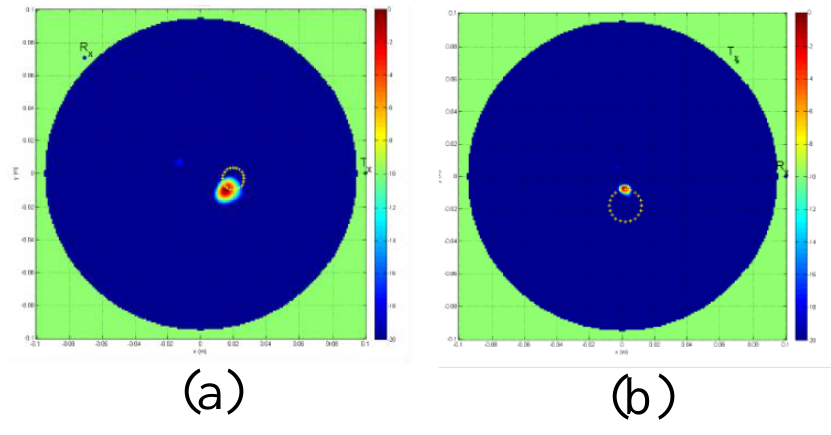
Figure 13. Reconstructed MT images obtained using the system developed by Pagliari et al. [69]. ( a ) A 12 mm tumour is indicated by the red spot inside a metallic cylinder breast phantom. ( b ) A 12 mm tumour is indicated by the red spot inside a dielectric cylinder breast phantom. Reprinted with permission from